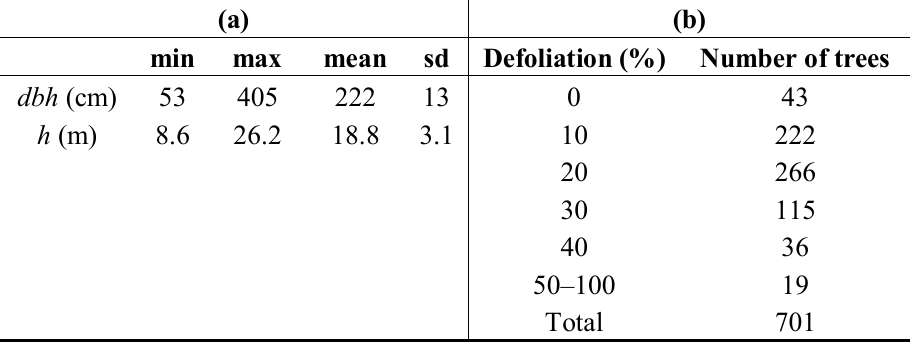
Table 1. Field tree measurement data, where dbh is the measured diameter-at-breast height (cm), h is the height of a tree (m) ( a ) and defoliation assessment (0%–100%) is the estimated needle loss in the field ( b